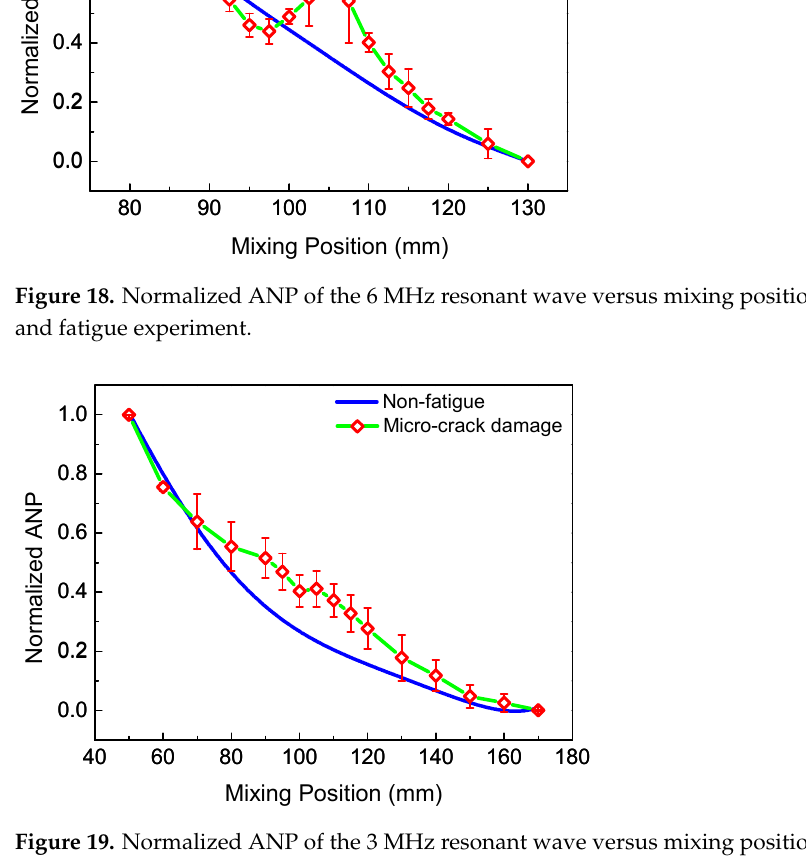
Figure 19. Normalized ANP of the 3 MHz resonant wave versus mixing position with